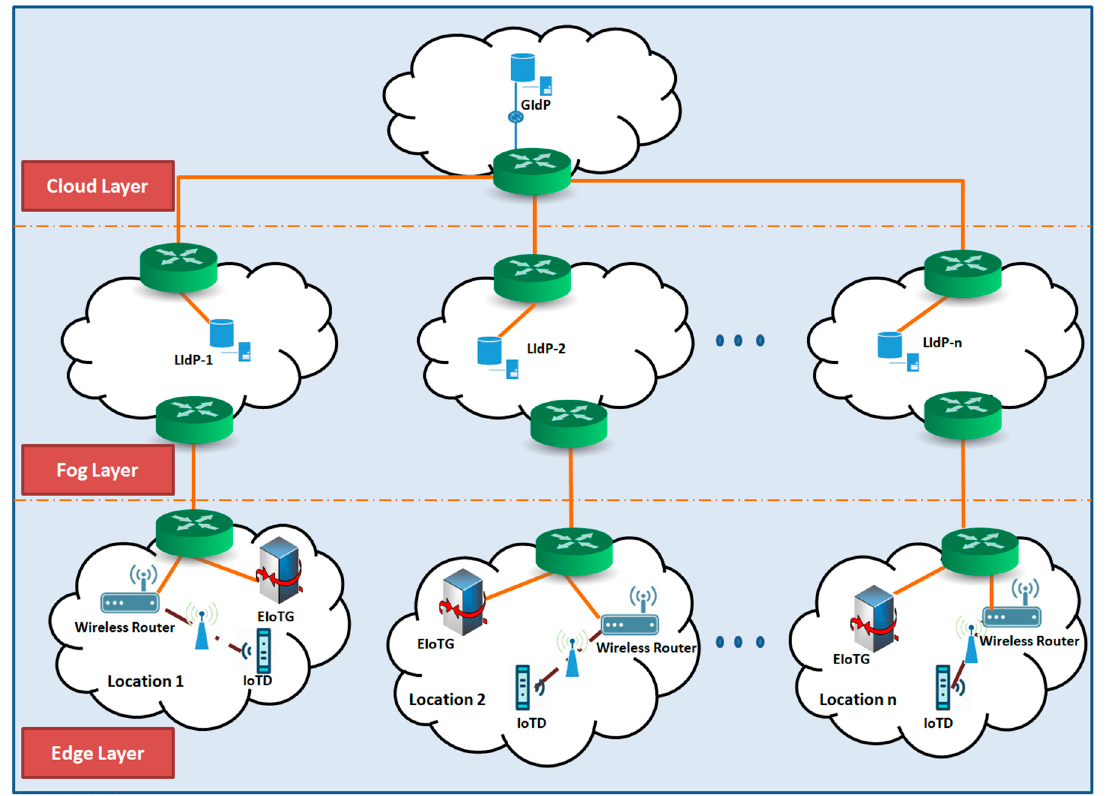
Figure 7. Proposed distributed and decentralized IoT identity management model.